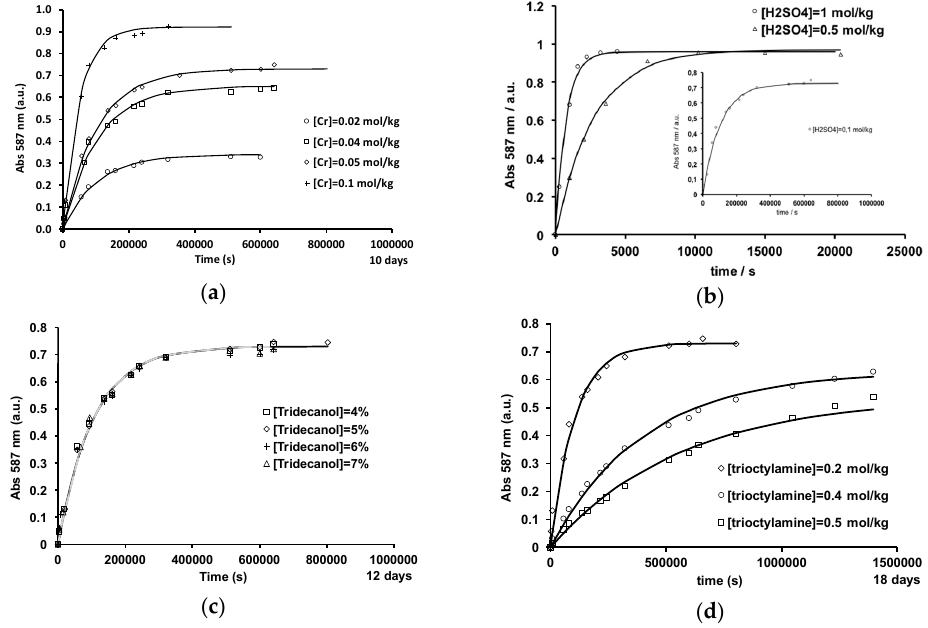
Figure 3. Variation of the absorbance at 587 nm of the aqueous phase during the chemical degradation of 0.2 mol·kg − 1 tri- n- octylamine in n- dodecane modified by 1-tridecanol. ( a ) aqueous phase = 0.1 mol·kg − 1 H 2 SO 4 + Cr(VI) at different concentrations; organic phase: 0.2 mol·kg − 1 tri- n- octylamine + 5 wt % 1-tridecanol; ( b ) aqueous phase = different concentrations of H 2 SO 4 + 0.05 mol·kg − 1 Cr(VI); organic phase: 0.2 mol·kg − 1 tri- n- octylamine + 5 wt % 1-tridecanol; ( c ) aqueous phase = 0.1 mol·kg − 1 H 2 SO 4 + 0.05 mol·kg − 1 Cr(VI); organic phase: 0.2 mol·kg − 1 tri- n- octylamine + different concentrations of 1-tridecanol, ( d ): aqueous phase = 0.1 mol·kg − 1 H 2 SO 4 + 0.05 mol·kg − 1 Cr(VI); organic phase: different concentrations of tri- n- octylamine + 5 wt % 1-tridecanol. Temperature = 25 °C. Data were fitted with Equation (4).